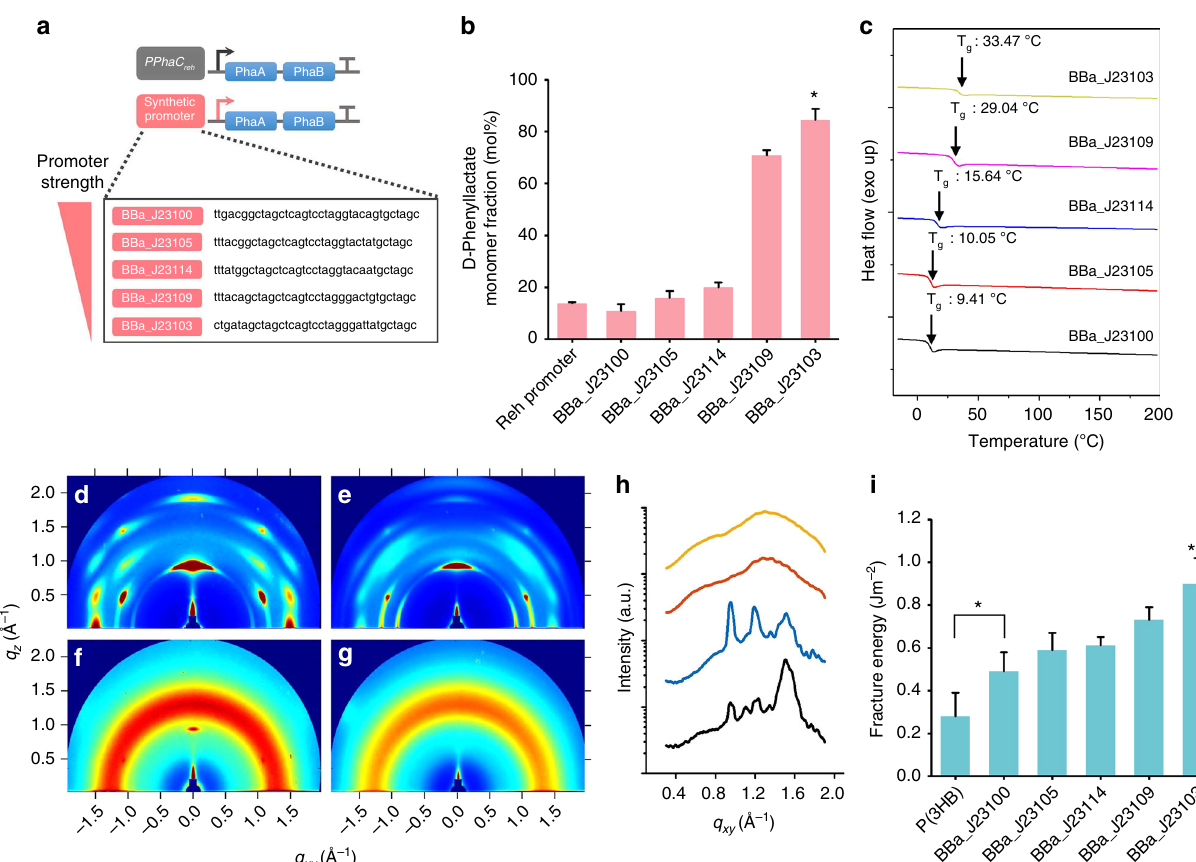
Fig. 4 Characterization of synthetic promoter driven aromatic polyesters. a Scheme of the PhaAB expression cassette. Analysis of D -phenyllactate monomer fraction b and differential scanning calorimetry (DSC) analysis c of copolymers produced by XB201TBAL strain expressing PhaAB under the synthetic Anderson promoters (BBa_J23100, BBa_J23105, BBa_J23114, BBa_J23109, and BBa_J23103) followed by overexpression of AroG fbr , PheA fbr , FldH, HadA, and PhaC1437. d – g Grazing-incidence X-ray scattering (GIXS) patterns of poly(3HB) d , poly(16.8 mol% D -lactate- co- 80.8 mol% 3HB- co- 1.6 mol% D - phenyllactate- co- 0.8 mol% D -4-hydroxyphenyllactate) e , poly(80.8 mol% 3HB- co- 35.5 mol% D -phenyllactate) f , and poly(52.1 mol% 3HB- co- 47.9 mol% D - phenyllactate) g . Colors indicate the intensity counts ranging from 0 (blue) to 10 5 (red). h In-plane line cut of GIXS patterns of each polymer ( d black; e blue; f orange; g yellow). i Dual cantilever beam (DCB) test of polymers. *P < 0.05 and **P < 0.01, by two-tailed t -test. Error bars represent s.d. of n =